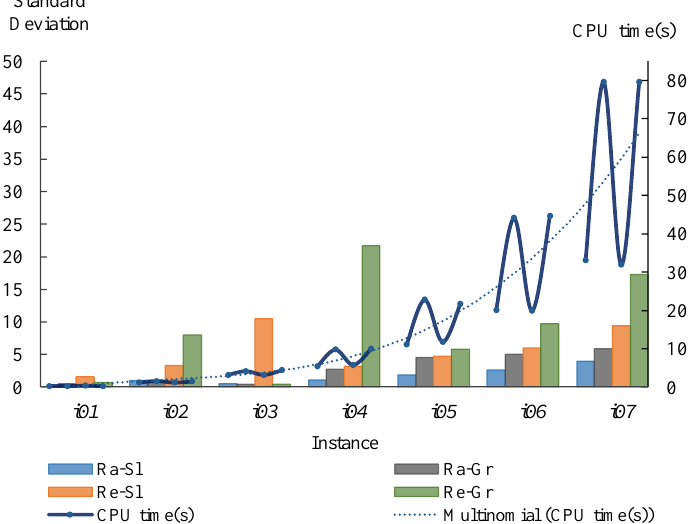
Figure 5. Standard deviation and CPU times obtained by different combinations of destroy– repair operators.